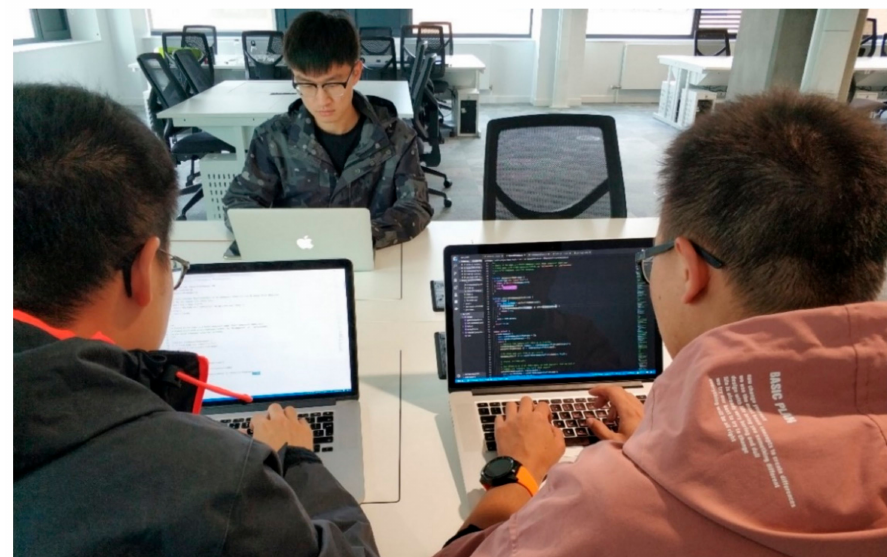
Figure 10. A picture taken in a laboratory at the University of Warwick, where three programmers are participating in the user evaluation of the CoVSCode prototype.